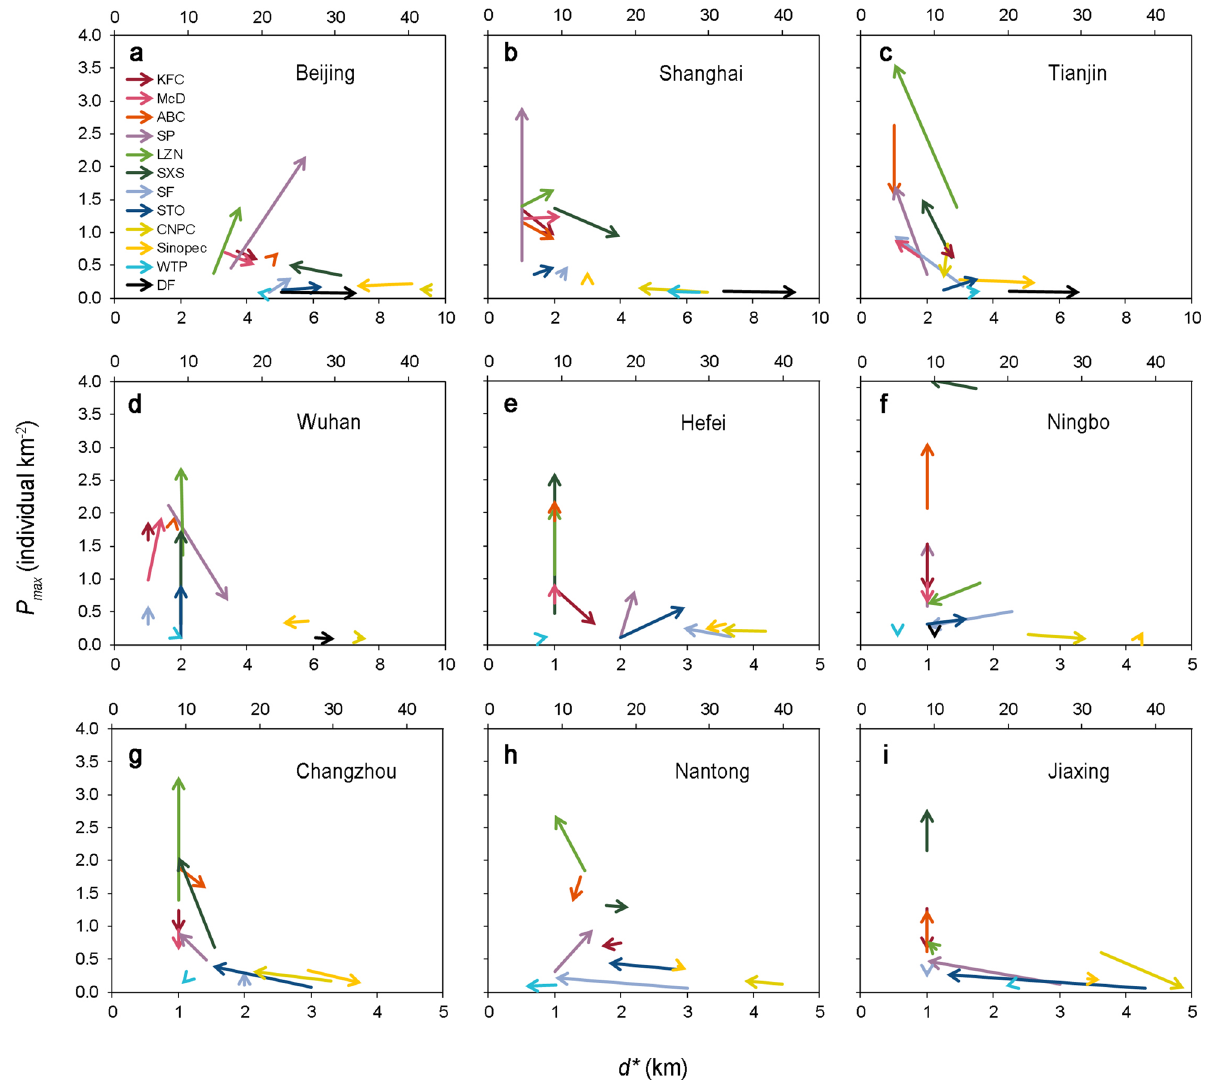
Figure 6. Dynamic changes in P max and d* of the density distribution curves of the city functional components in cities of different sizes over time. The arrows indicate the changes in P max and d* . Only the WTP and DF components use the top coordinates. ( a ) Beijing; ( b ) Shanghai; ( c ) Tianjin; ( d ) Wuhan; ( e ) Hefei; ( f ) Ningbo; ( g ) Changzhou; ( h ) Nantong; ( i ) Jiaxing. The abbreviations of the component names are the same as those in Fig.